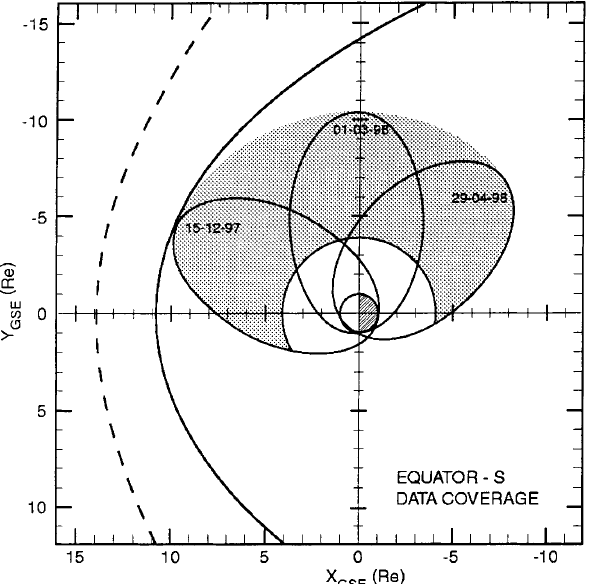
Fig. 1. The Equator-S spacecraft, booms not deployed. One gun- detector unit of the Electron Drift Instrument is seen left from center, to the right the Ion Composition Instrument. Several antennae on the bottom side are